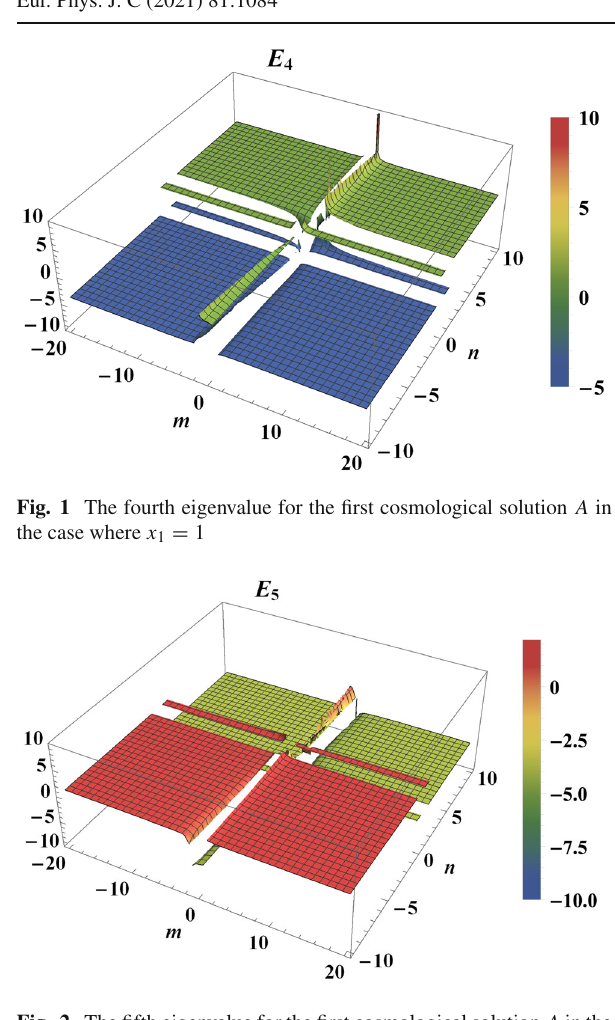
Fig. 2 The fifth eigenvalue for the first cosmological solution A in the case where x 1 =